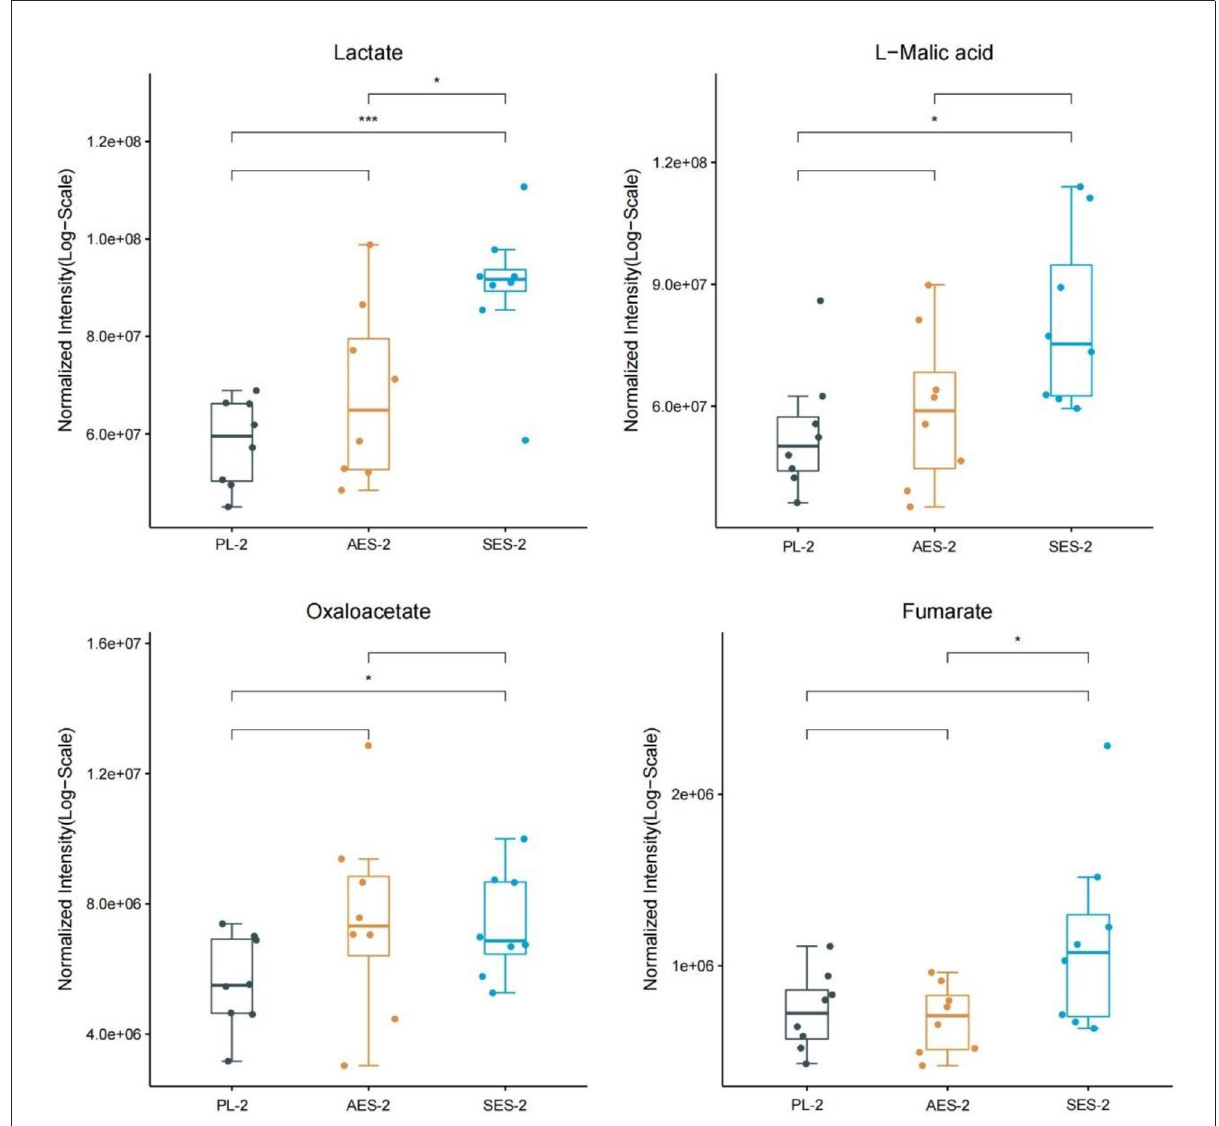
FIGURE10 Metabolite expression trends between three groups. (PL, Placebo group; AES, acute enteric-coated sodium bicarbonate group; SES, serial enteric-coated sodium bicarbonate group; 2: 50min after the third WAT). * Indicates p < 0.05; ** indicates p < 0.05; *** indicates p < 0.001.